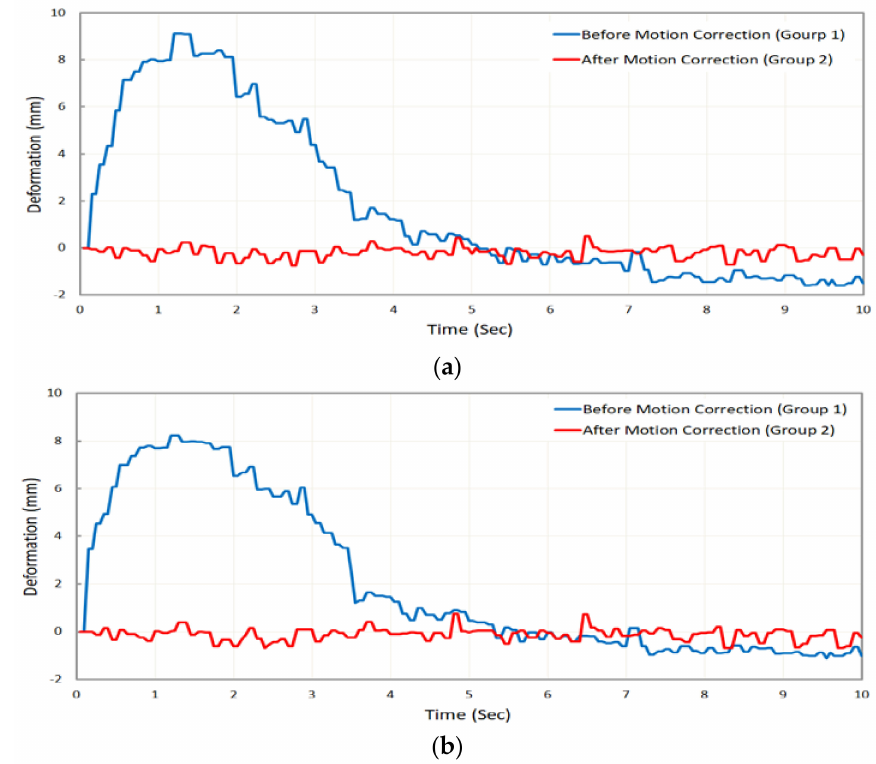
Figure 13. Comparison of bridge deformation measurement results before and after image motion correction: ( a ) at target A; ( b ) at natural